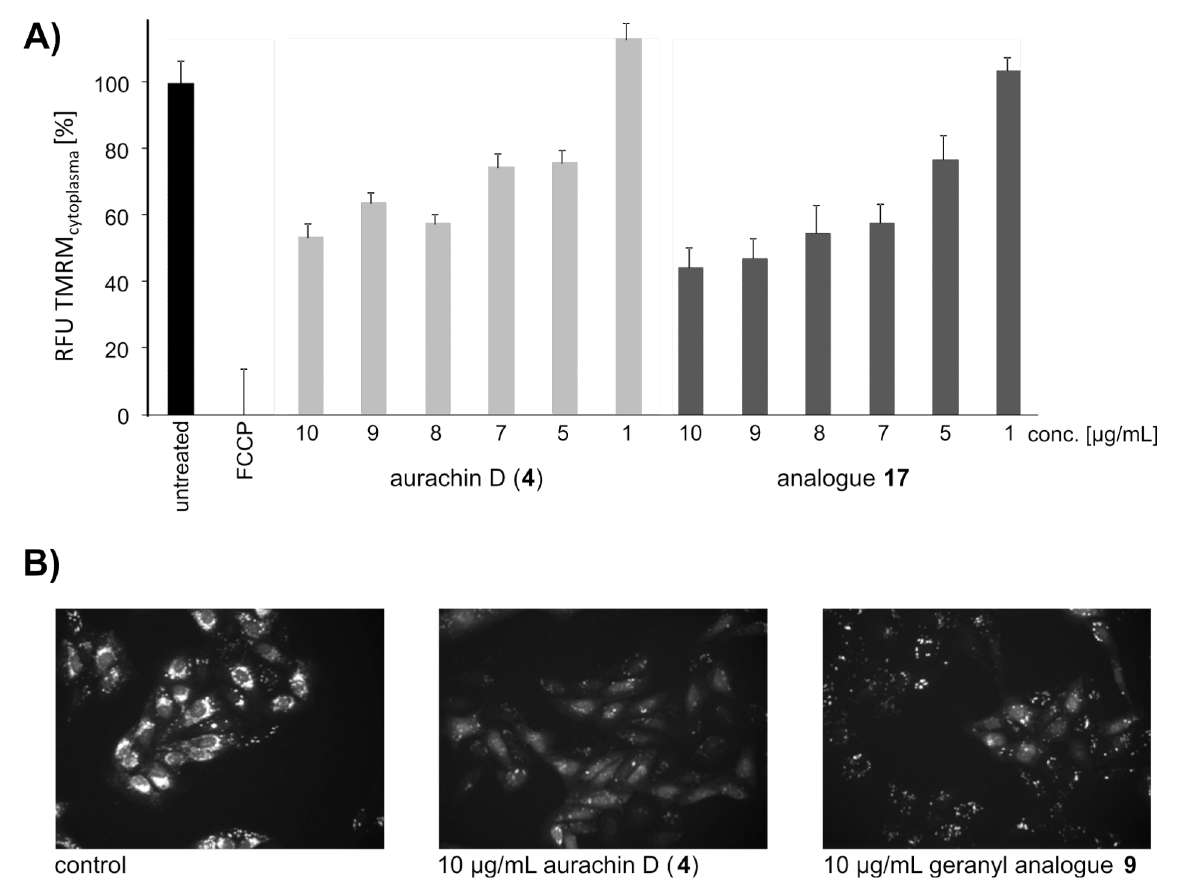
Figure 2: (A) Loss of mitochondrial membrane potential in human U-2 OS osteosarcoma cells that were treated with aurachin D ( 4 ) and analogue 17 . Images were acquired on a BD Pathway855 automated microscope and subsequently processed in AttoVision v1.6.2. The relative MMP was calcu- lated based on TMRM fluorescence intensity in the cytoplasmic segments. The value of the negative control (untreated cells) was set to 100% and the value of FCCP-treated cells (positive control) was set to 0%. Bars represent the mean ±SEM of all cellular segments within a well. (B) Representative HCS images of U-2 OS cells that were treated with aurachin D ( 4 ) or the geranyl analogue 9 . Cells were labeled with TMRM and imaged in the rhodamine channel at 200× magnification.